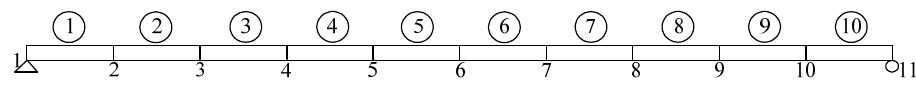
Figure 4. Bridge considered for the simulation, ( a ) bridge elevation, ( b ) bridge cross-section, ( c ) girder cross-section.